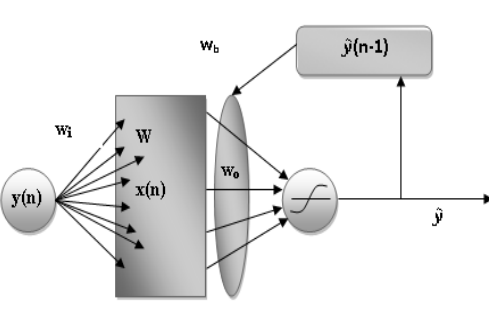
Fig. 4. Echo State